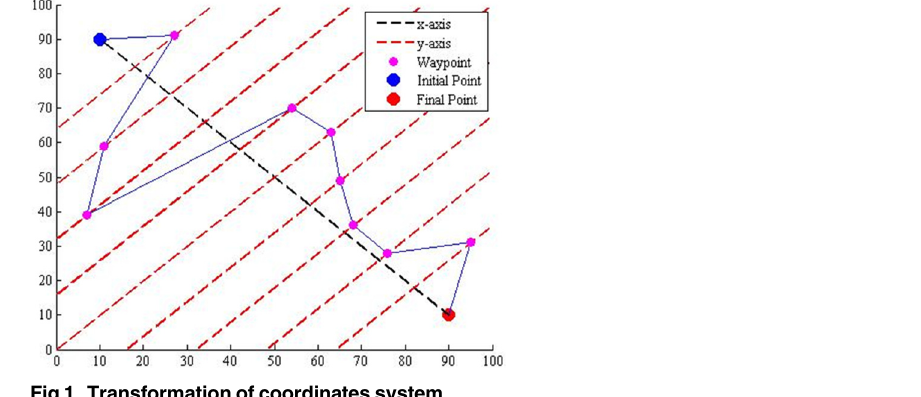
Fig 1. Transformation of coordinates